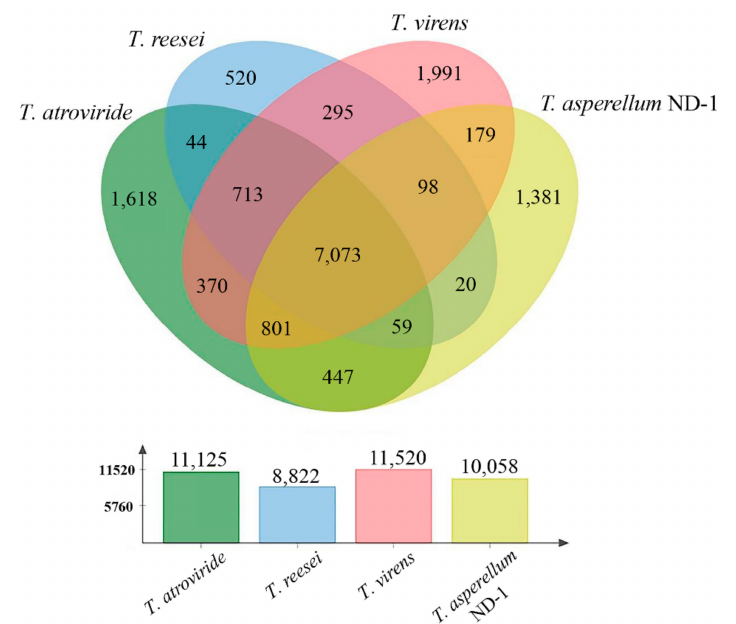
Figure 5. Distribution of orthologues of T. atroviride IMI 206040, T. virens Gv-298, T. reesei QM6a, and T. asperellum